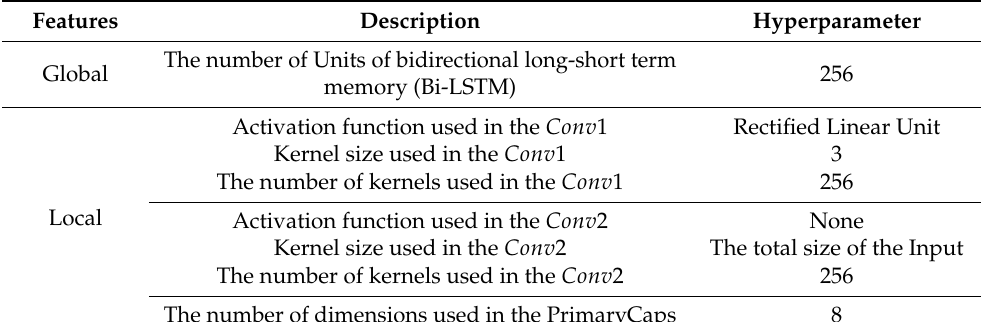
Table 3. Hyperparameters used in the